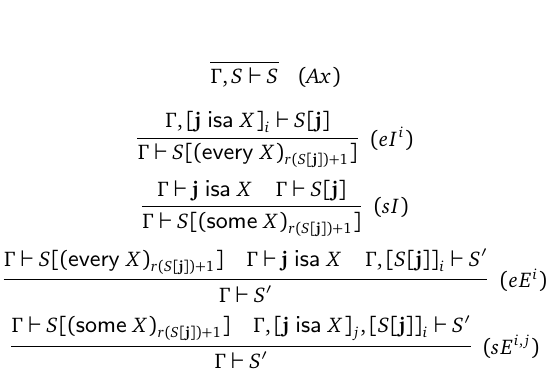
Figure 2: The meta-rules for N +